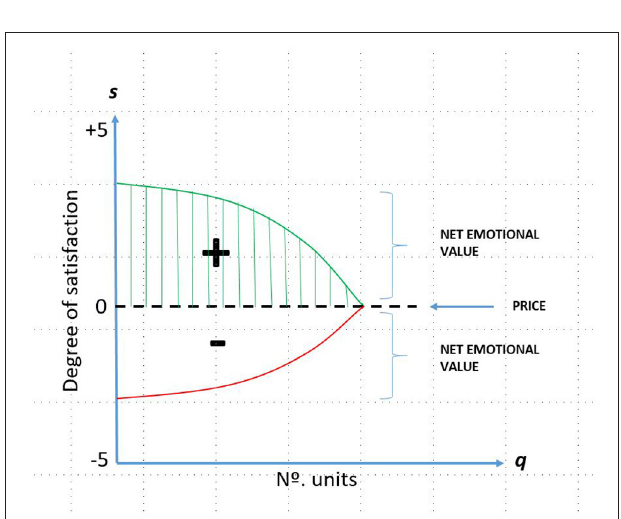
FIGURE 3 | Net emotional value price. Source: own compilation based on Samuelson and Nordhaus (1989). i is the (1, ..., n ) utility perceived by n number of individuals